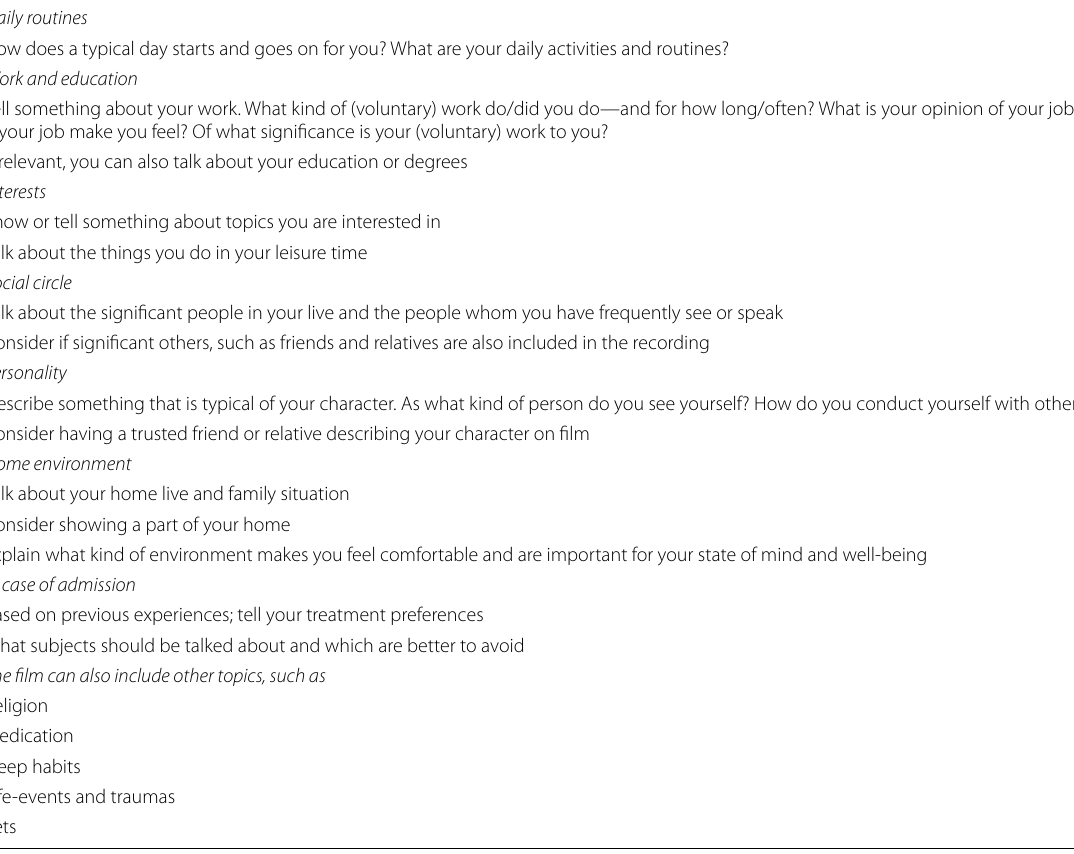
Table 1 Topics to be discussed in preparation of the script Daily